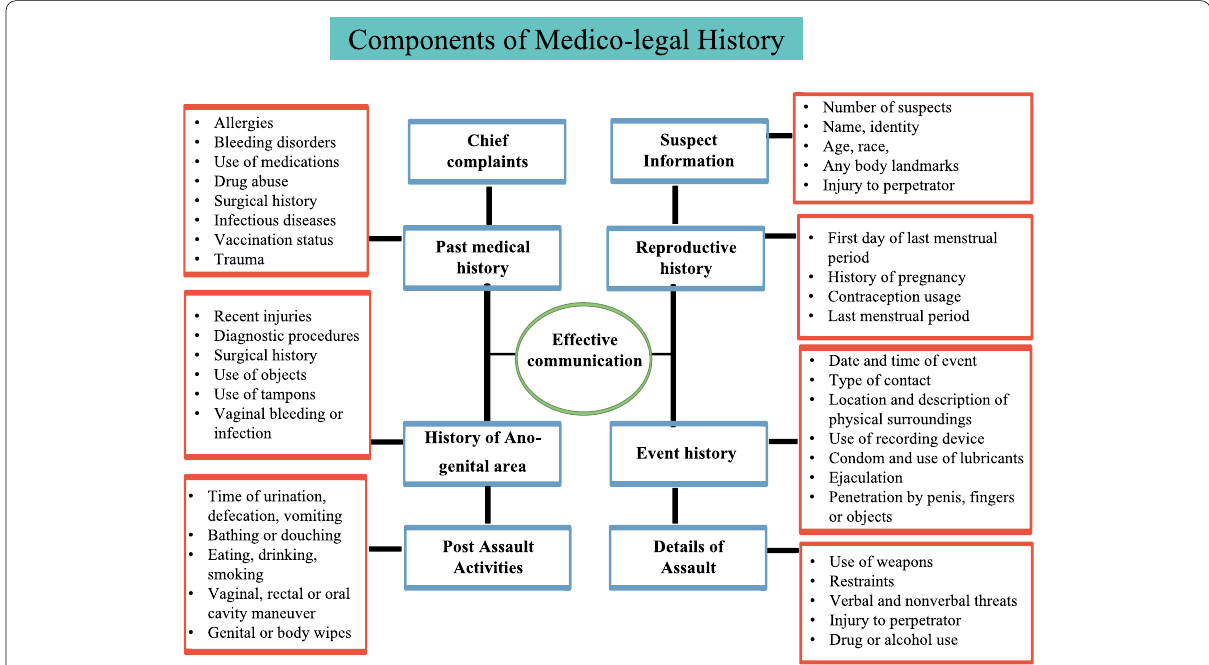
Fig. 2 The key components of medico-legal history